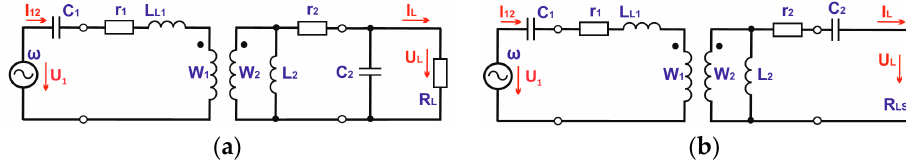
Figure 6. Matching of the IPT equivalent circuit with two inductances through serial capacitor at the primary side capacitor at the secondary side: ( a ) parallel and ( b ) series.